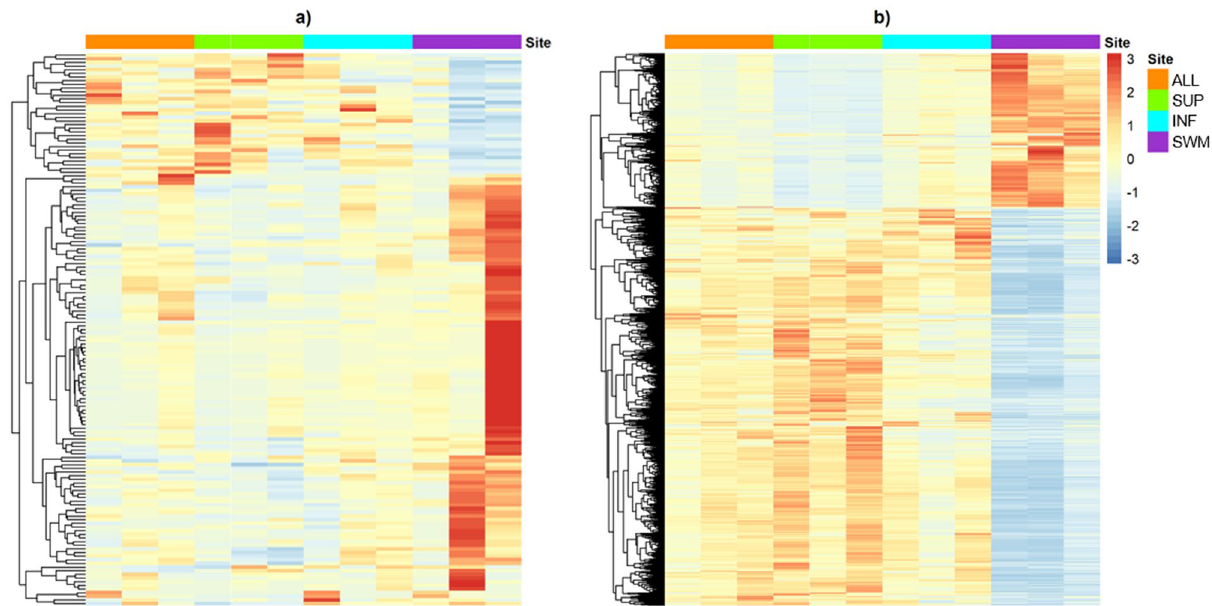
Figure 2. Unique and common DEG between AD and HC. Heatmaps showing the distinct expression profile of the DEG found uniquely in the HC ( a ) or AD ( b ) comparisons.